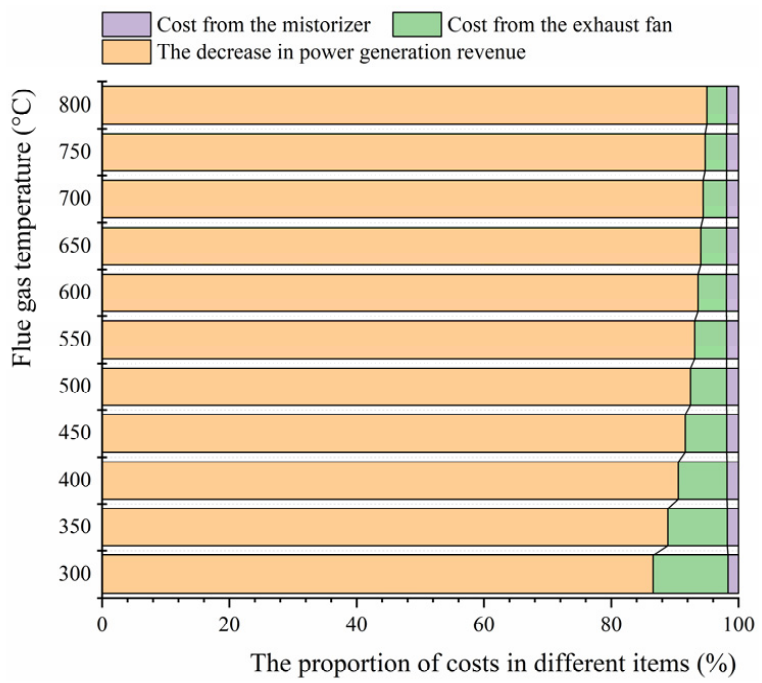
Figure 3. The proportion of costs in different items.